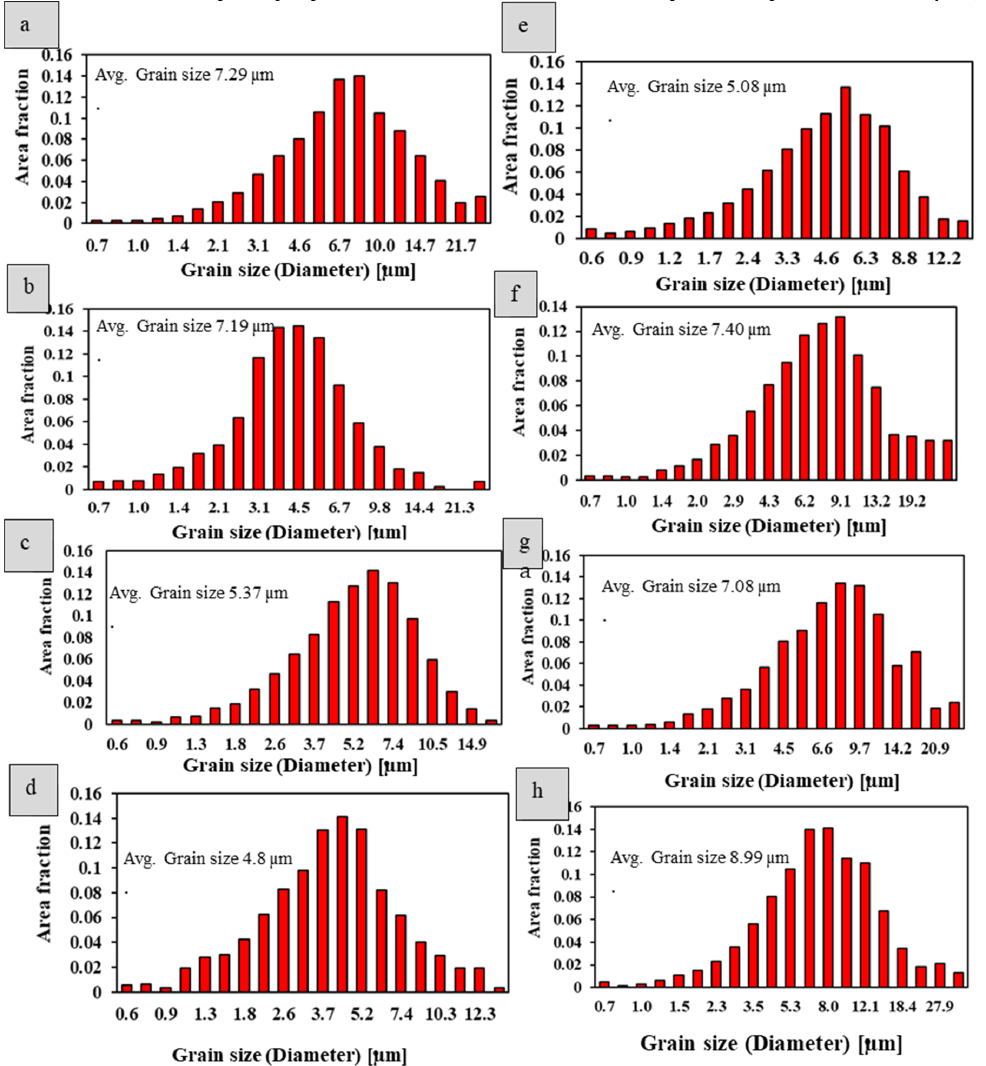
Figure 7. Grain size distribution in the subsurface region of microalloyed steel specimen ( a ) in unpeened condition; after LSP at 1064 nm with ( b ) 3 GW/cm 2 , ( c ) 6 GW/cm 2 , ( d ) 9 GW/cm 2 , and ( e ) 12 GW/cm 2 ; and after LSP at 532 nm with ( f ) 3 GW/cm 2 , ( g ) 6 GW/cm 2 , and ( h ) 9 GW/cm 2 .